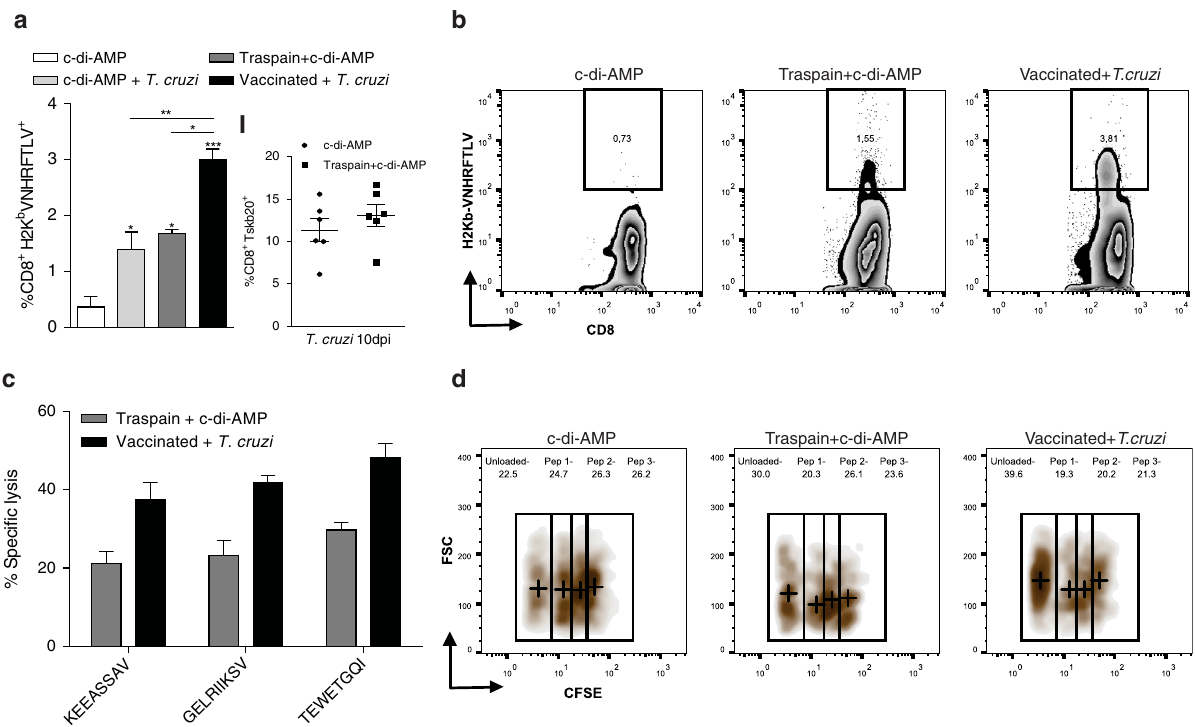
Fig. 5 Pathogen exposure triggers an expansion of antigen-speci fi c memory CD8 + T cell subset. Blood of C57BL/6 mice immunized (30 dpi) or immunized and challenged with 250,000 CL culture trypomastigotes (10 dpi) was analyzed for VNHRFTLV-speci fi c CD8 + T cells by tetramer staining ( a ). Percentage of pathogen-speci fi c, vaccine unrelated CD8 + T cells (Tskb20) by tetramer staining in blood (I). Zebra-plots showing VNHRFTLV-tetramer + population on indicated groups ( b ). In vivo CTL assay ( c ). Spleen cells from C3H donor mice were loaded with peptides, KEEASSAV (Nt-Cz domain), GELRIIKSV ( α -linker-motive), and TEWETGQI (ASP2 domain), or unloaded. Cells were stained with CFSE, mixed in an equal ratio, and i.v. injected to naïve (c-di-AMP), Traspain+c-di-AMP immunized or Traspain+c-di-AMP vaccinated and T. cruzi infected mice at 45 dpi (Vaccinated + T. cruzi ). Representative density-plot showing percentage of CFSE populations in the indicated groups. Crosses represent the median value of each dimension in each gate ( d ). pep 1: KEEASSAV, pep 2: GELRIIKSV, pep 3: TEWETGQI. Results are expressed as mean ± SEM, and represent at least three independent experiments, n = 6 per group ( a , b ) and n = 3 per group ( c , d ), *** p < 0.001, ** p < 0.01, * p < 0.05. 1way-ANOVA + Tukey ’ s multiple comparisons test ( a